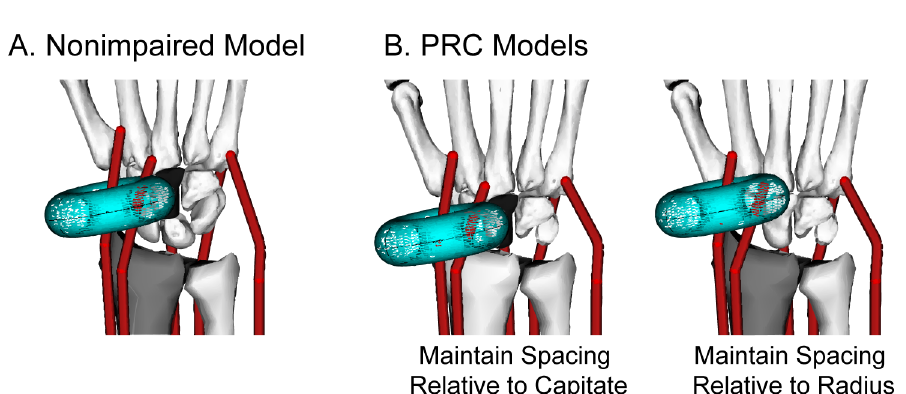
Fig 3. Muscle-Tendon Path Assumptions for the PRC Model. Illustration of a wrapping surface in (A) the nonimpaired and (B) the PRC models. In the nonimpaired model, the location of the wrapping surfaces is defined relative to the proximal row. In the PRC models, the location of the wrapping surfaces was redefined relative to the capitate by either maintaining the distance between the wrapping surface and capitate or maintaining the distance between the wrapping surface and radius. Shading of the capitate (black) and radius (gray) provides a visual reference to compare the location of the wrapping surface between the nonimpaired and PRC models. The torus shaped wrapping surface (shown for the ECRL) is representative of the wrapping surfaces implemented for each wrist muscle.